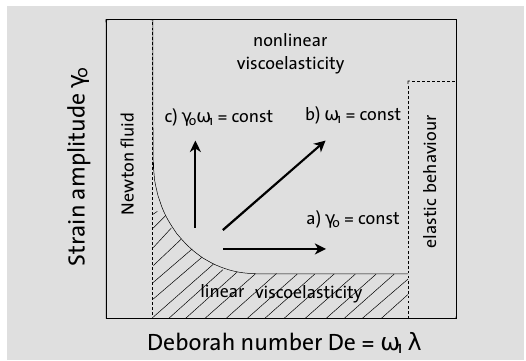
Figure 1: The Pipkin diagram [3, 4] displays the general types of viscous and elastic behaviour in the linear and nonlinear regime. Different possible FT-rheology experi- ments are indicated and also described in section